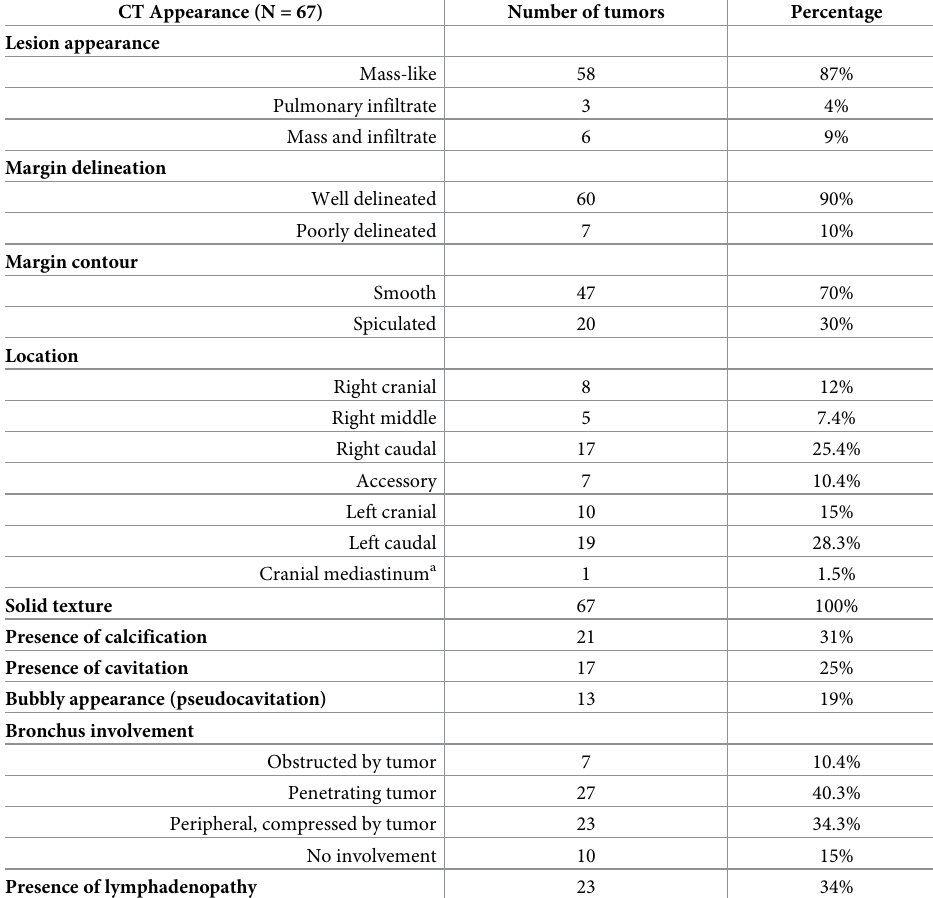
Table 2. Lung tumor characteristics identified on review of thoracic CT